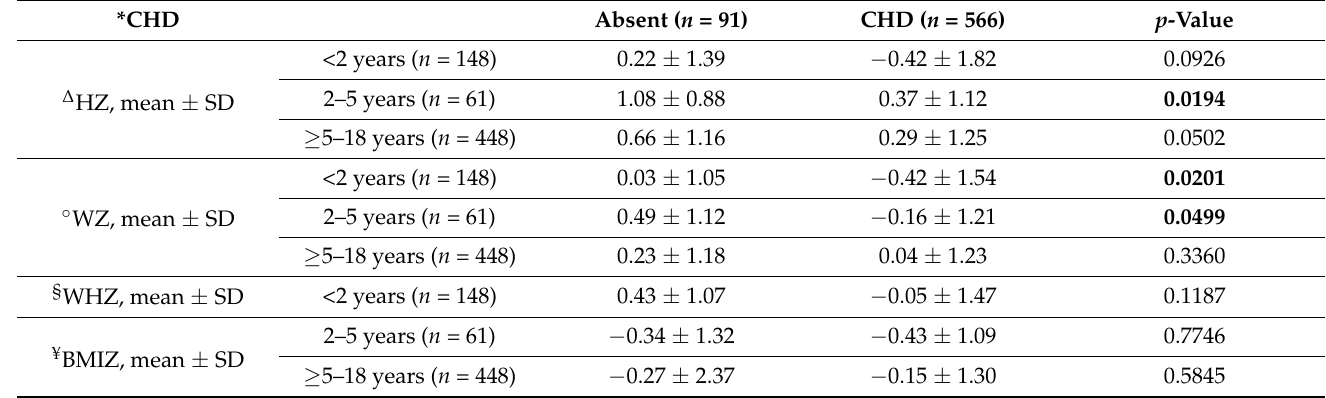
Table 2. HZ, WZ, BMIZ and WHZ differences between healthy children and children with CHD stratified for age